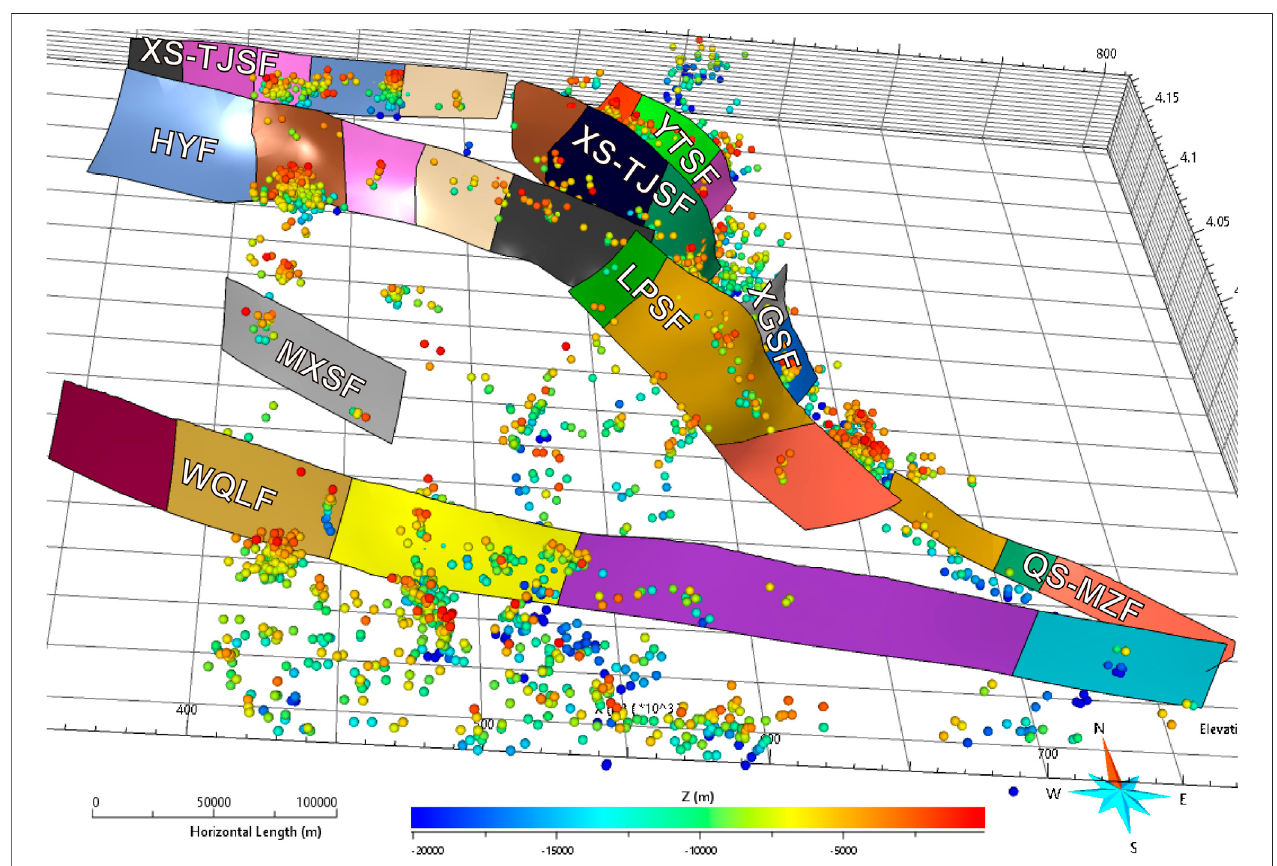
FIGURE 13 | V3 model fault segmentation. The different colored parts of each fault represent the segmentation of this fault in the V3 model.